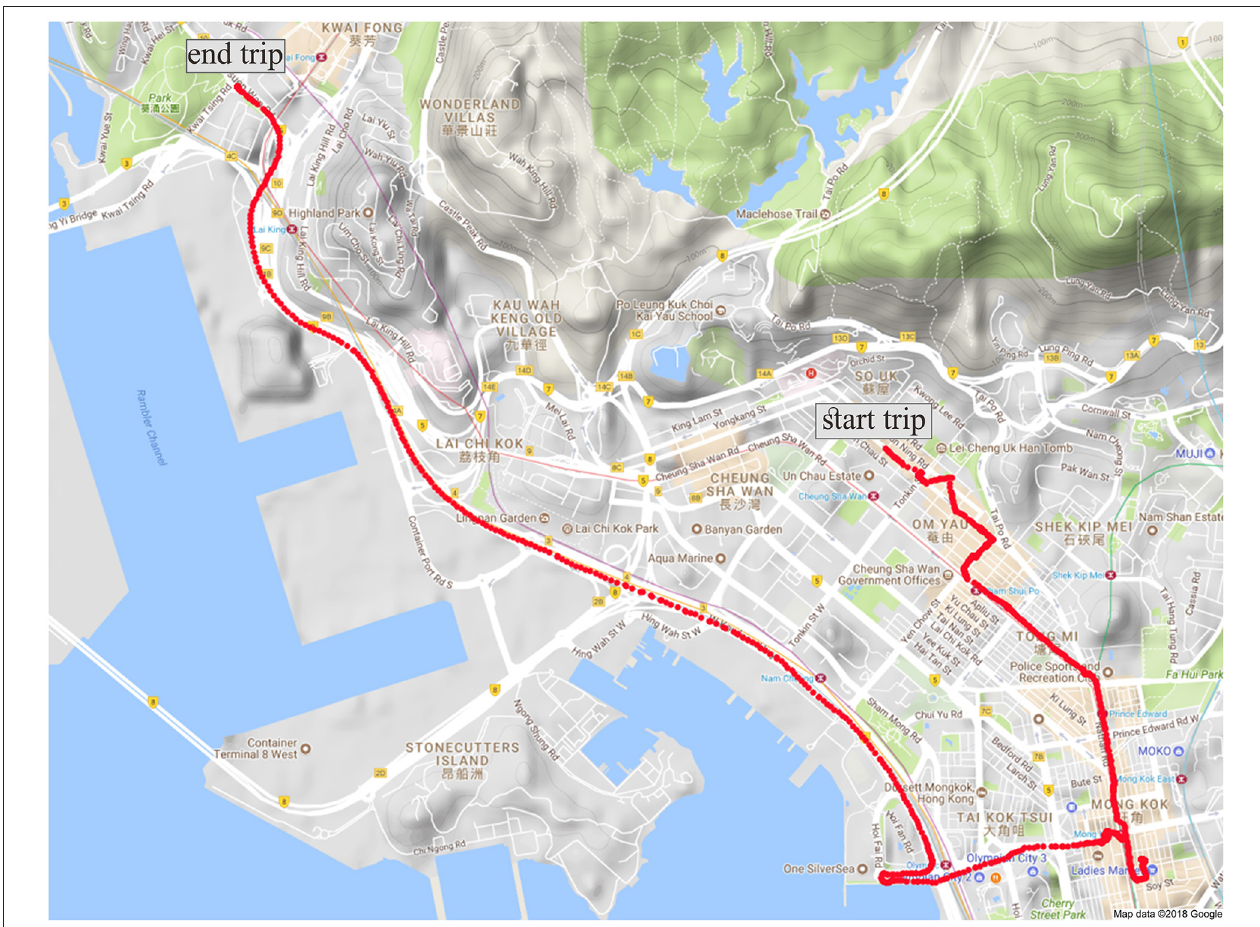
FIGURE 4 | GPS signal spot recordings (red dots) of the trip presented in Figure 3